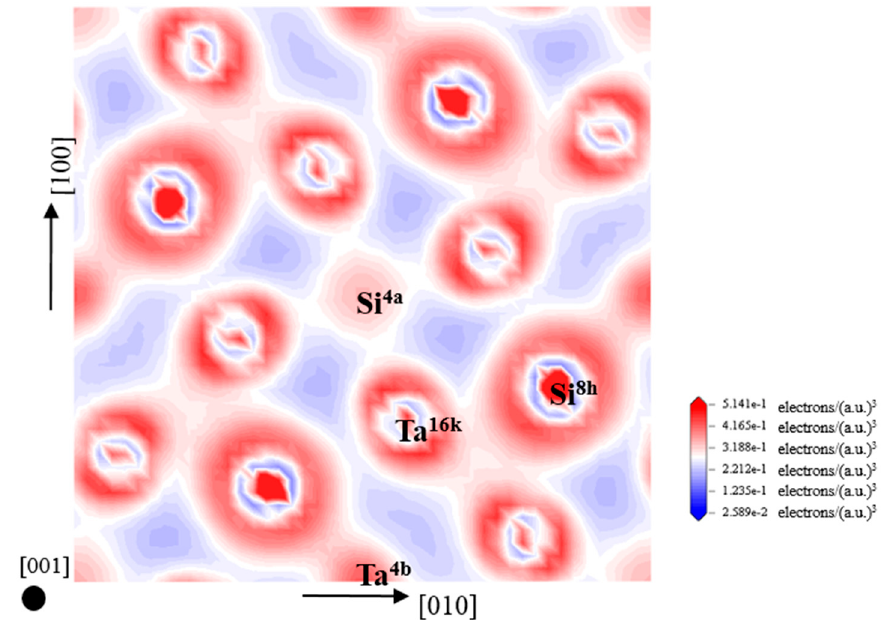
Figure 7. Calculated partial density of states (DOS) for ( a ) Ta 20 Si 12 ; ( b ) Ta 20 Si 11 Al 8h and ( c ) Ta 19 Ti 4b Si 12 .